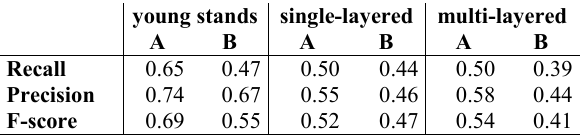
A=Li2012 B=MultiCHM – hit accuracies weighted with